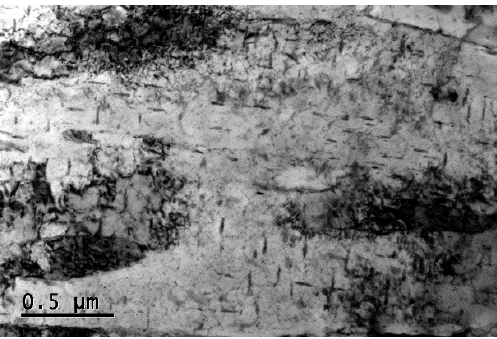
Figure 13. MC carbides, M 2 C carbides and dislocation groups in alloy 2.